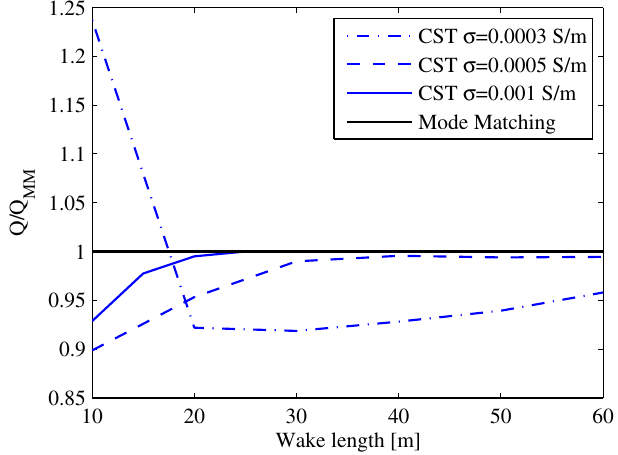
FIG. 7 (color online). Evaluation of Q over wake length for mode matching and CST. CST parameters: 1 M mesh cells, σ ¼ 4 cm. Mode matching parameters: S ¼ 10 , P ¼ 10 b